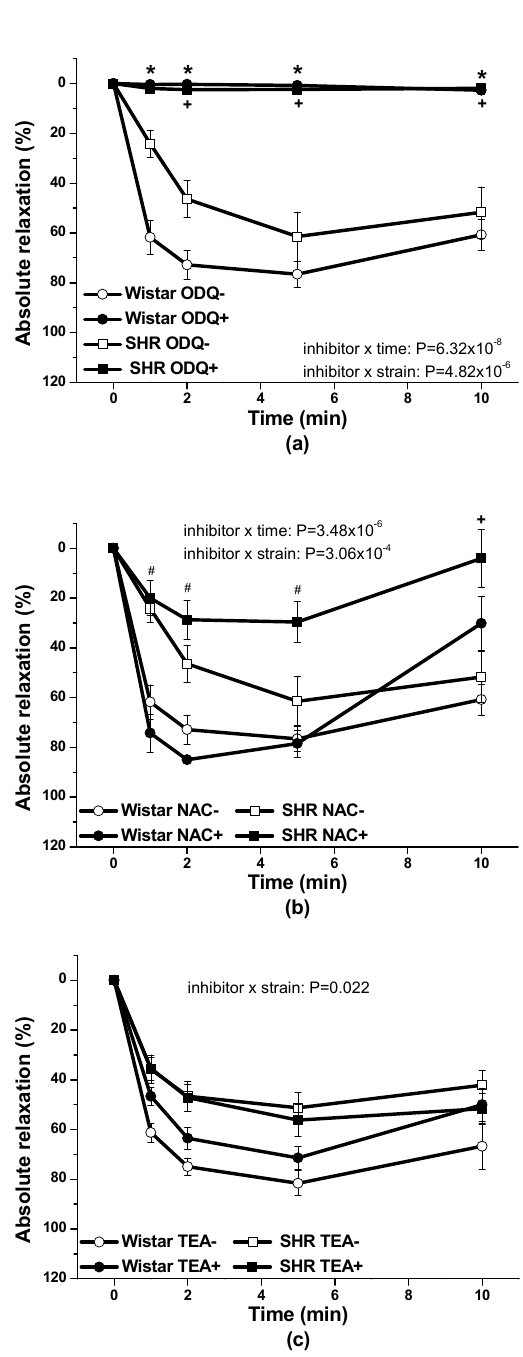
Figure 11. The possible mechanism of the vasorelaxation induced by S / GSNO products in rat thoracic aorta. The comparison of the absolute relaxation induced by S / GSNO products (0.5 µ mol / L) before and after the treatment: ( a ) with inhibitor of soluble guanylate cyclase (ODQ; 10 µ mol / L); ( b ) HNO scavenger (NAC; 1 mmol / L); and ( c ) non-specific inhibitor of K + channels (TEA, 1 mmol / L) in normotensive Wistar and spontaneously hypertensive rat (SHR). Results are expressed as the mean ± S.E.M. Significant di ff erences were evaluated by tree-way ANOVA for main factors: used time, inhibitor and strain. Bonferroni post hoc test was used to describe the di ff erences in mean values of the experimental groups. * p < 0.05 with respect to the value of the S / GSNO response without inhibitor in Wistar rats within the appropriate graph; + p < 0.05 with respect to the value of the S / GSNO response without inhibitor in SHR within the appropriate graph; # p < 0.05 with respect to the value of the S / GSNO response with inhibitor in Wistar rats within the appropriate